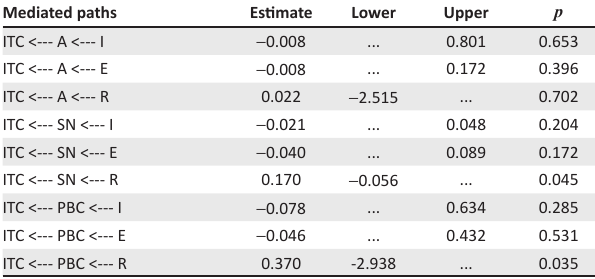
TABLE 3: Standardised regression weights. Mediated paths